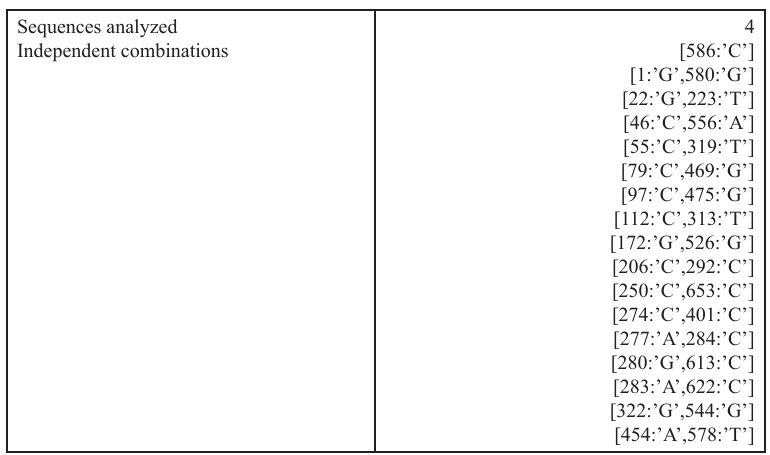
Table 3. Molecular diagnosis of the Okutanius ellenae gen. et